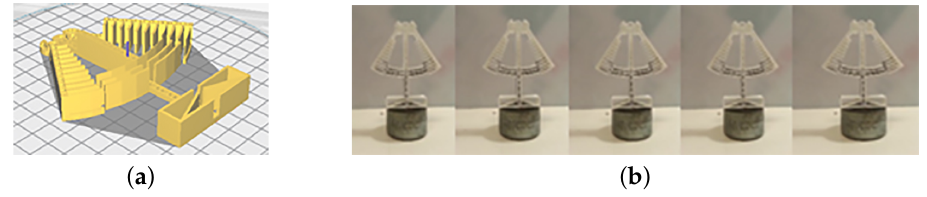
Figure 8. Magnetic actuation at the macroscale: ( a ) bulk stl file (left and right wings); and ( b ) motion sequence of the armed